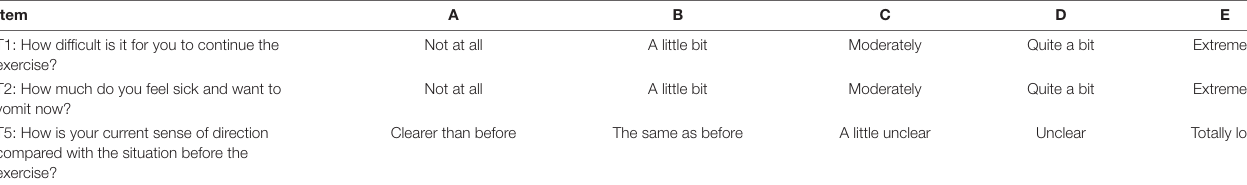
TABLE 1 | Example of certain items of acute exercise-induced fatigue.